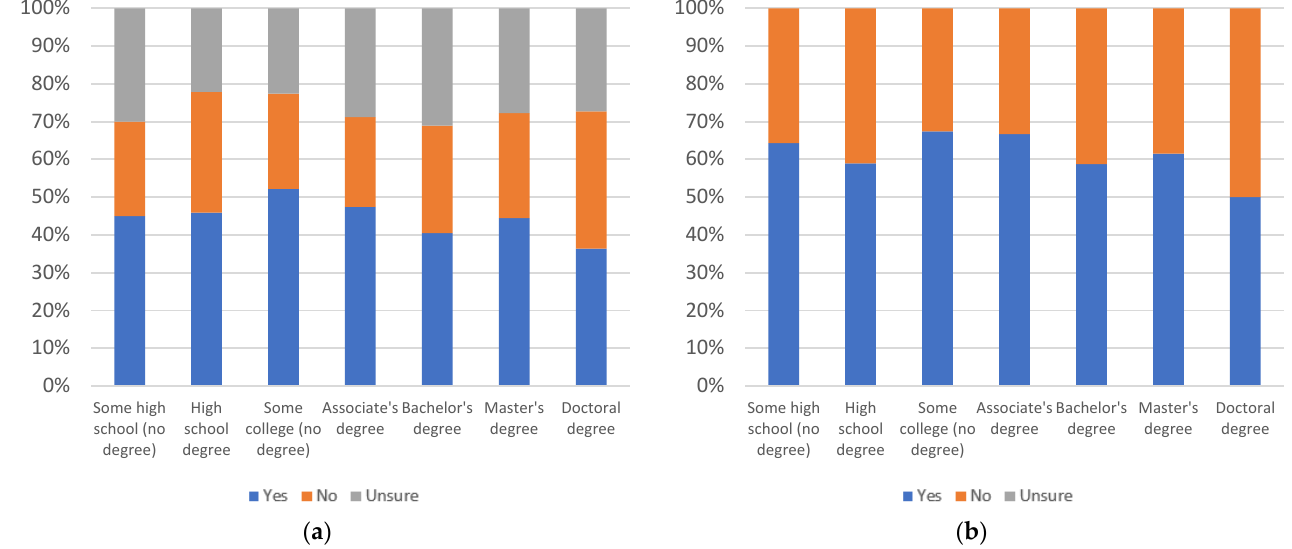
Figure 111. Label others’ use, by education level: ( a ) with uncertain respondents (left) and ( b ) without uncertain respondents (right).